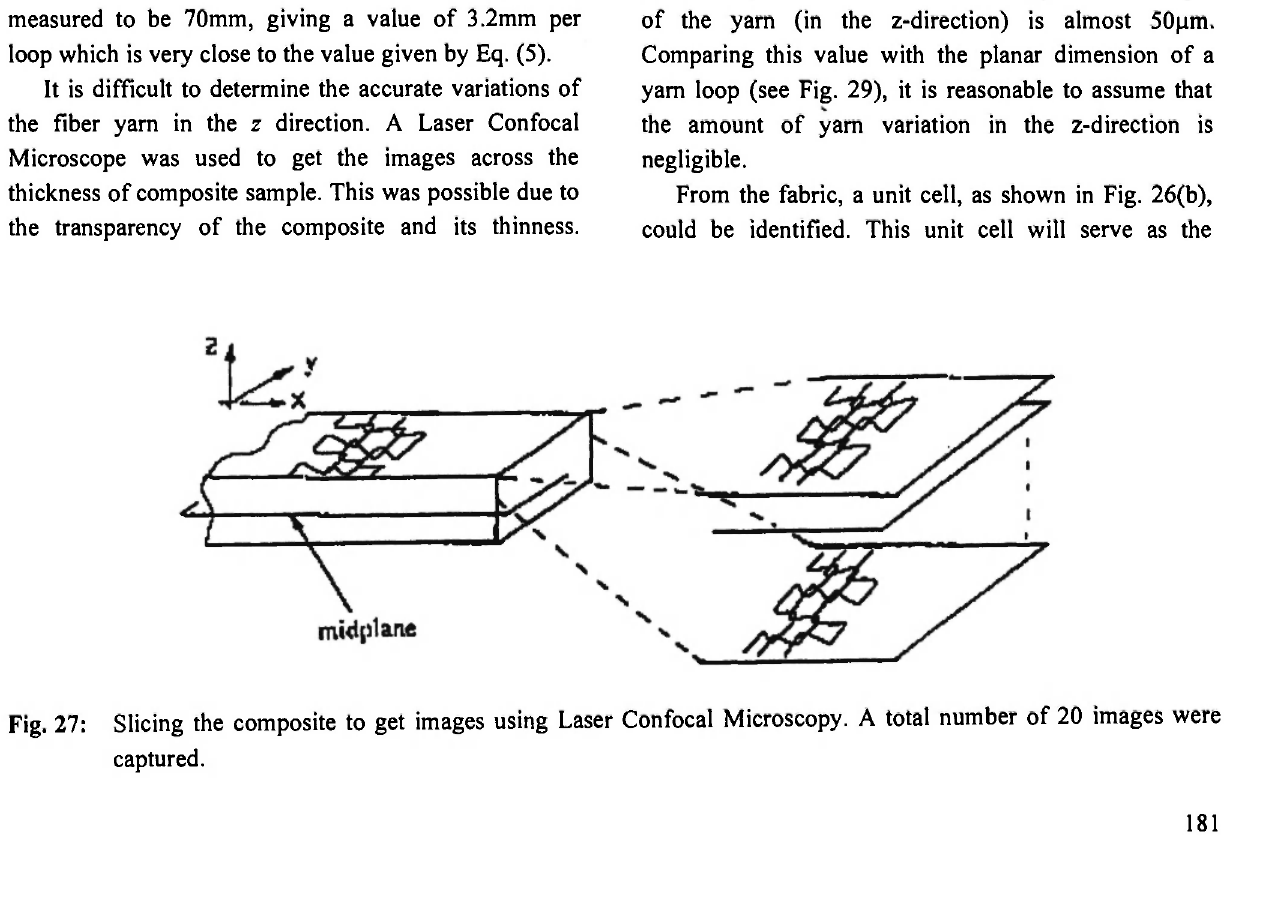
Slicing the composite to get images using Laser Confocal Microscopy. A total number of 20 images were